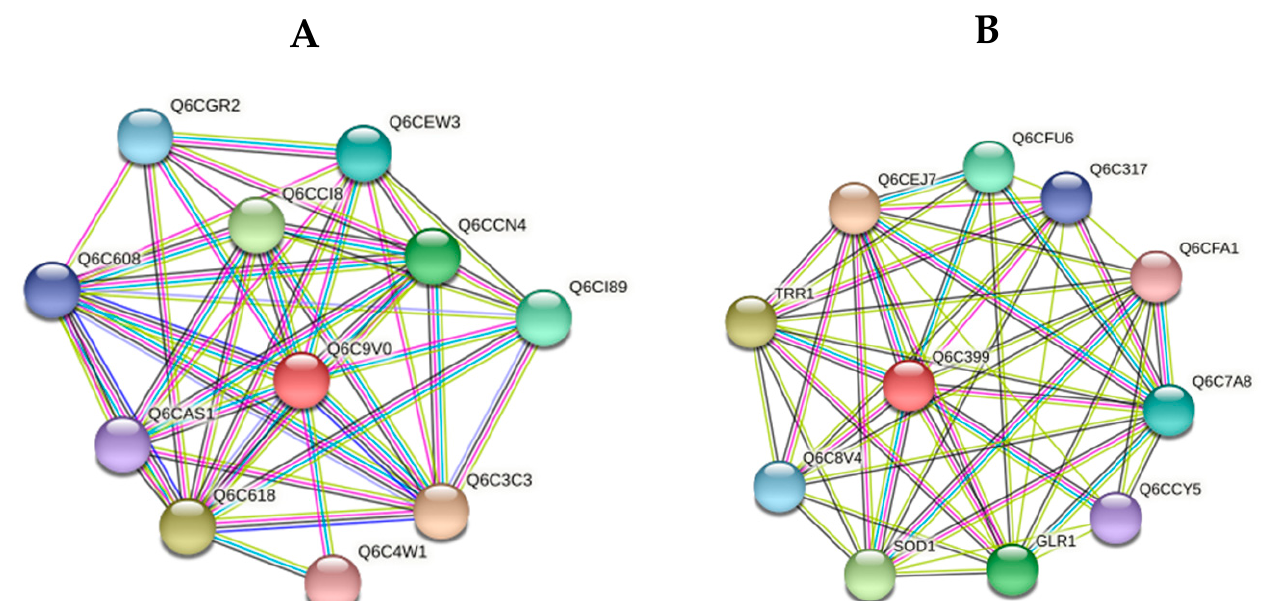
Figure 5. Network analyses of functional associations and/or interactions of induced proteins in response to heat stress. Different clusters of interacting proteins were identified using the STRING software with the highest conformity score. The information on the proteins is summarized in the Supplementary Section (Table S3). ( A ) SSA4 heat shock protein of HSP70 family (YALI0D08184p, YALI0D22352p) ( B ) Thioredoxin (CPAR2_200490)